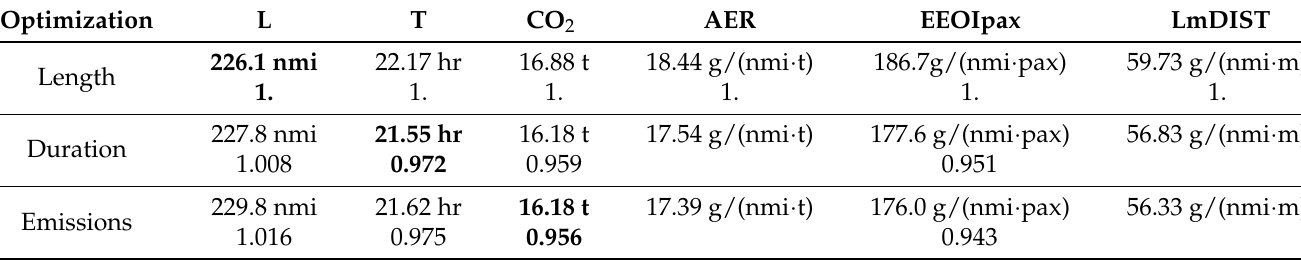
Table 5. Performance metrics and some CIIs for the routes in Figure 2, both in physical and relative units, for the optimization objectives given in the rows. Values in bold correspond to the optimal metric values L ∗ , T ∗ , and (CO 2 ) ∗ .